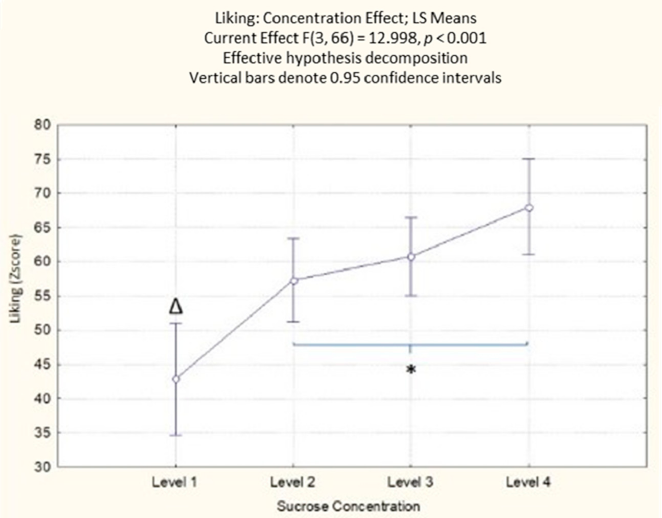
Figure 2. Concentration effect on liking responses with different sucrose concentration levels. The order of the levels corresponds with the different sucrose amounts (38; 83; 119; 233 g/kg). * Denotes a significance level < 0.05, while ∆ indicates a significant difference from all other sucrose levels <0.001.